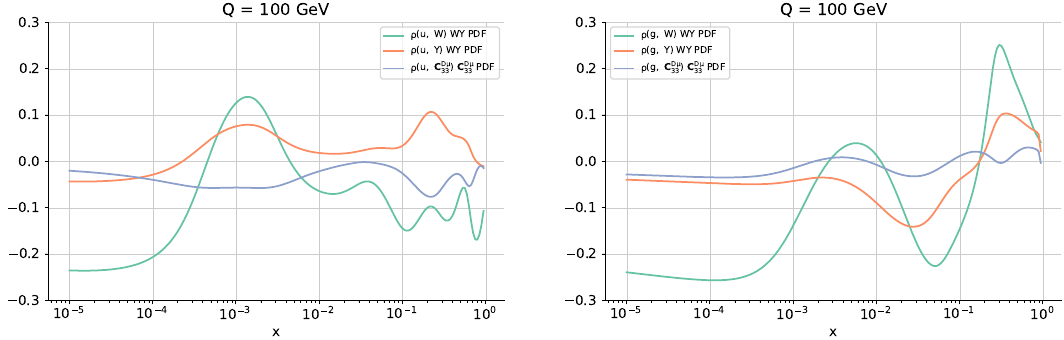
Figure 11 . Correlation coefficients, defined in eq. (4.5), between the W (green), Y (orange), C Dµ (blue) and the up quark PDF (left panel) and gluon PDF (right panel) computed at Q = 100 GeV as a function of the momentum fraction x . The PDFs used to compute the correlation coefficients are those obtained in the simultaneous fit of ( W, Y ) and the PDFs described in section 4.4 (in the case of the green and orange curves) and those obtained in the simultaneous fit of C Dµ PDFs described in section 4.5 (in the case of the blue